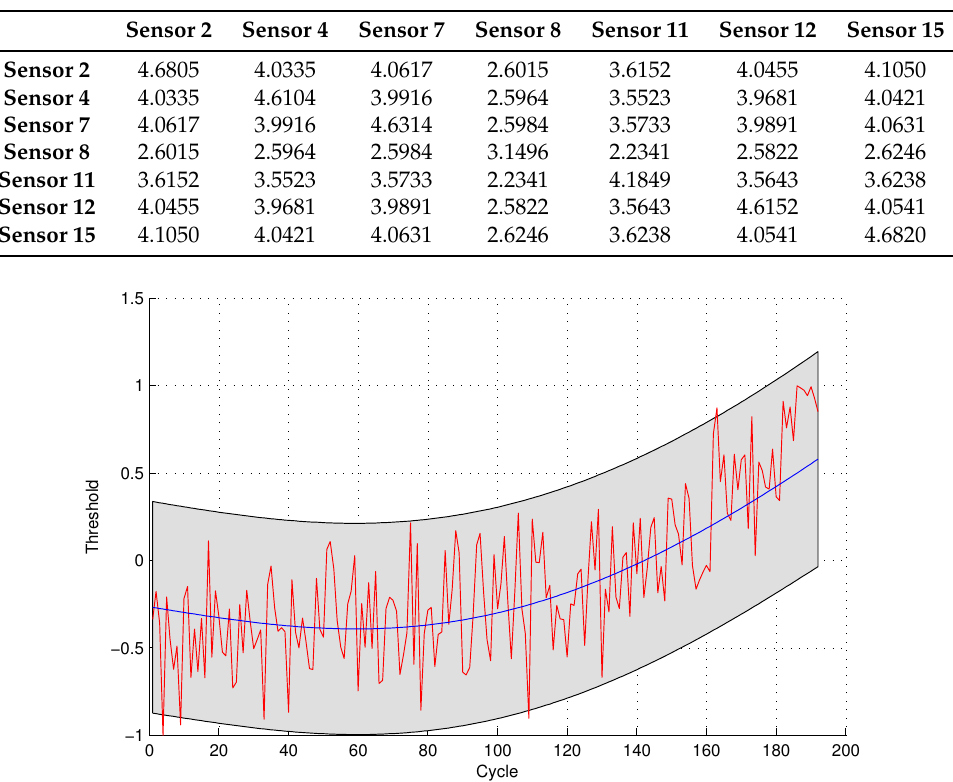
Table 5. Mutual information values among sensors selected by observing strategy for data set 1.